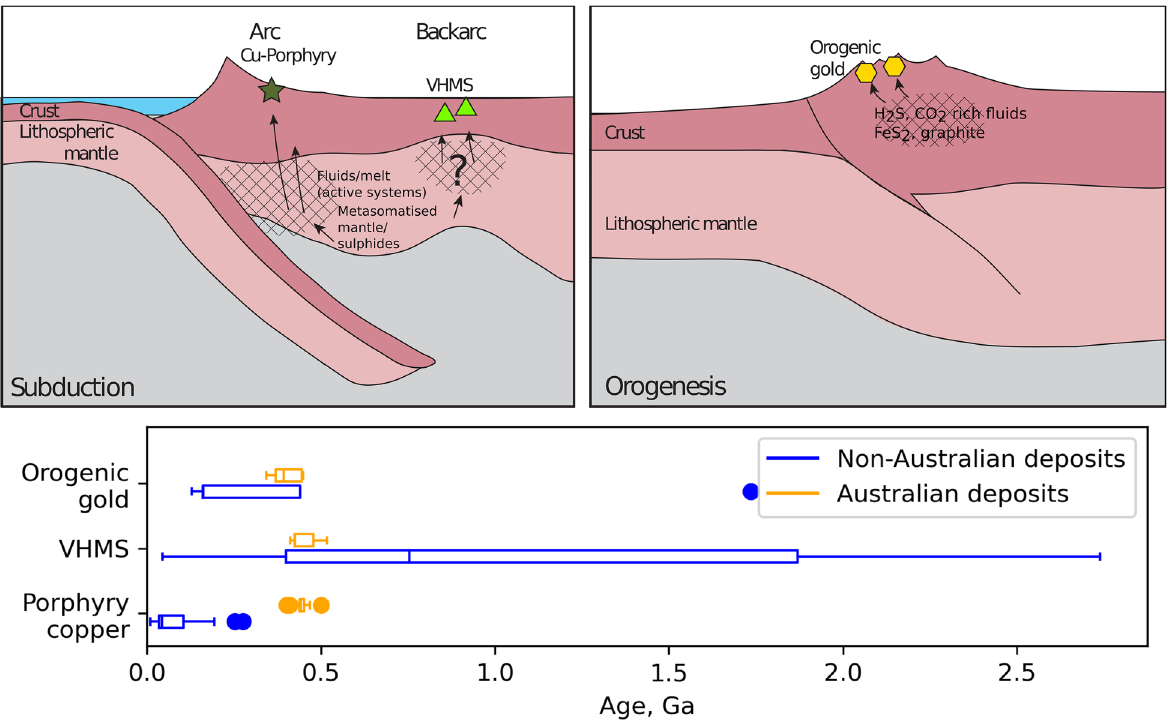
Figure 3. Top panel: schematic diagram showing the metal source regions beneath Porphyry Cu, VHMS, and Orogenic gold deposits. Porphyry Cu deposits are associated with arc environments, while VHMS deposits generally form in the backarc. Conductors likely represent metasomatism in the source regions of these deposits. Orogenic gold deposits are associated with carbonic, reduced fluids in orogenic environments, which our analysis suggests are sourced in the middle to lower crust. Bottom panel: age of the deposits analyzed, showing that, with the exception of the Australian deposits, the porphyry copper deposits are < 275 Ma while the VHMS deposits have a much wider range of ages. In the box and whisker plots, the boxes show first and third quartiles, the center line shows the median, the whiskers are limited to 1.5 time the inter quartile range from the median and filled dots show outliers.